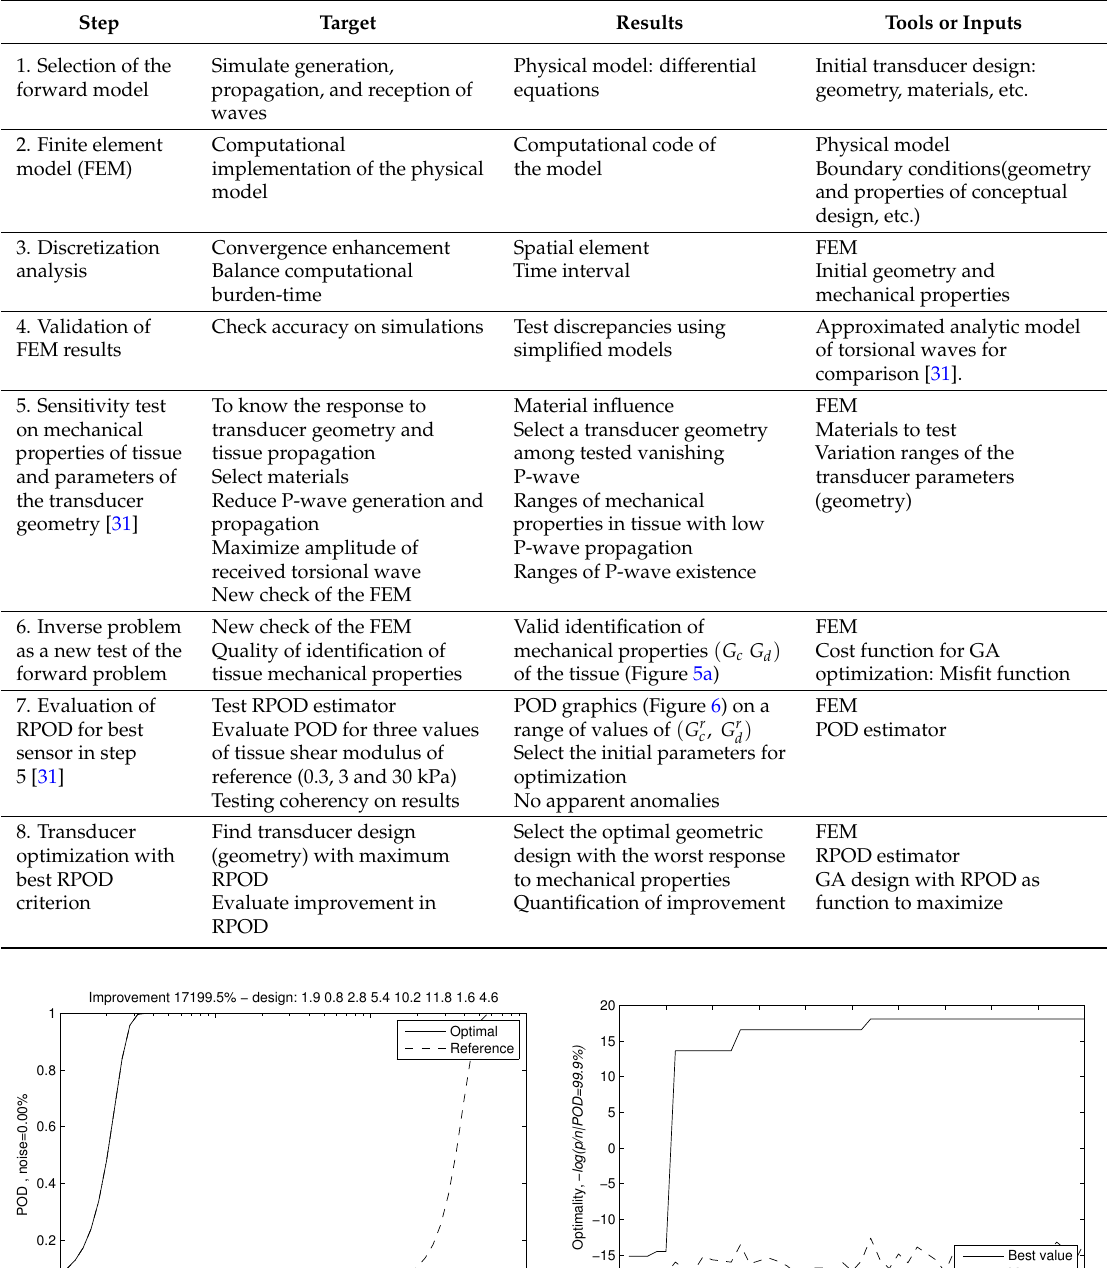
Table 4. Methodology of phase 2.